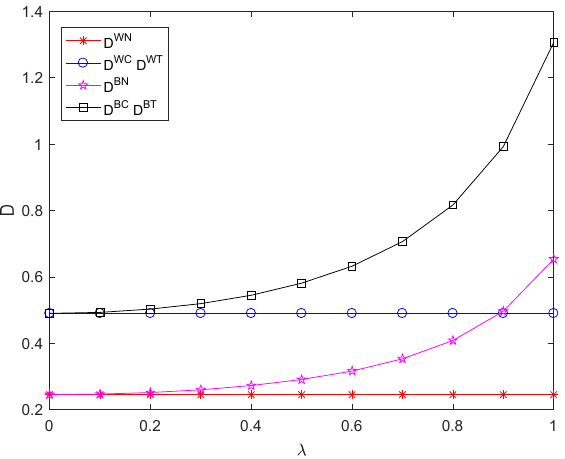
Figure 4. The demand in different scenarios.